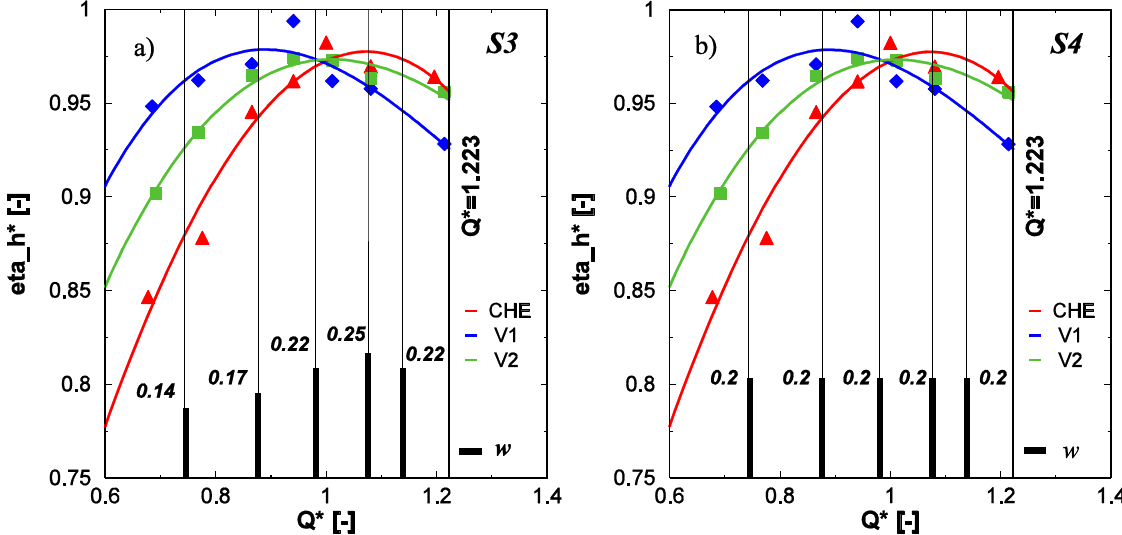
∗ Fig. 7. The hydraulic ef fi ciency ( h h ) versus the normalized discharge ( Q *) and the weights associated to two scenarios: (a) scenario No. 3 ( S3 ) and (b) scenario No. 4 ( S4